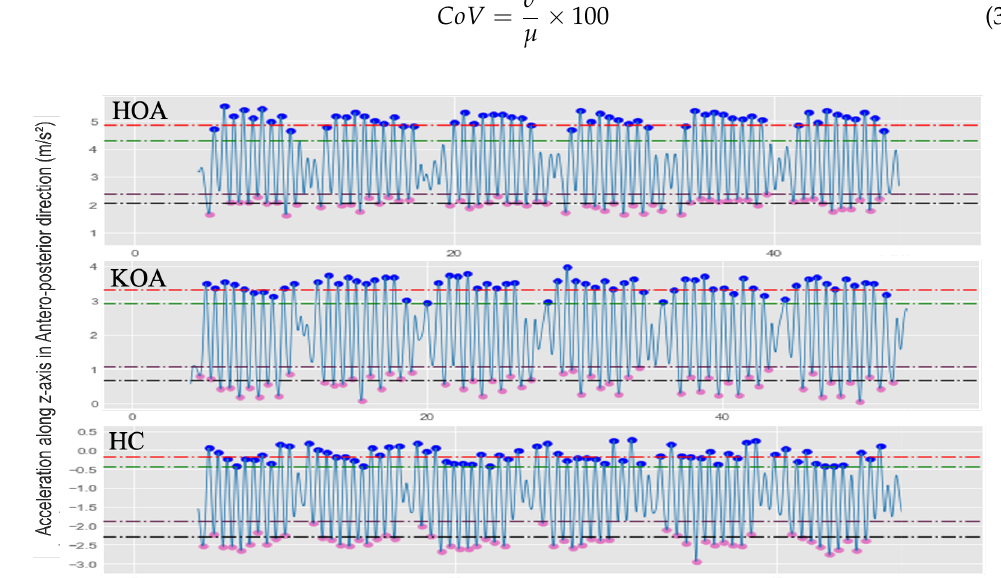
Figure 11. Illustration examples of the various MPH thresholds to determine the local maxima and local minima for HOA, KOA, and HC subjects. The red dash line is MPH = µ peaks ; the green dash line is MPH = µ peaks − σ peaks ; the plum dash line is MPH = µ valleys ; the black dash line is MPH = µ valleys + σ valleys .